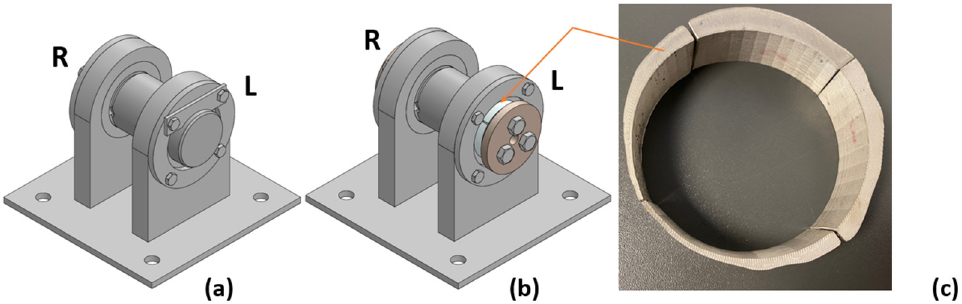
Figure 5. Test equipment, with ( a ) the cylindrical pin, ( b ) expanding pin, and ( c ) 3D-printed boss on the left (L) support of the expanding pin. Table 2. Material quality for tests 1–5. Part: Load-bearing